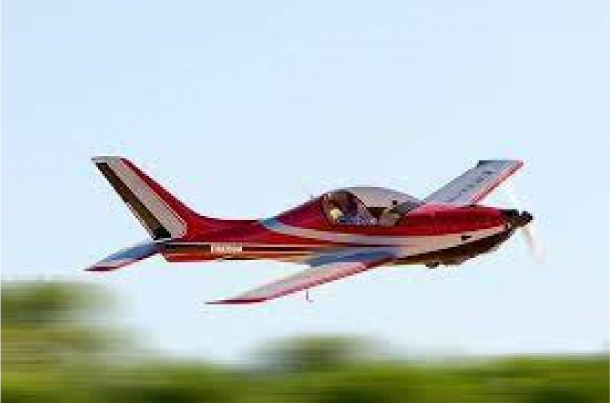
Figure 2. The ultralight Promecc Freccia.